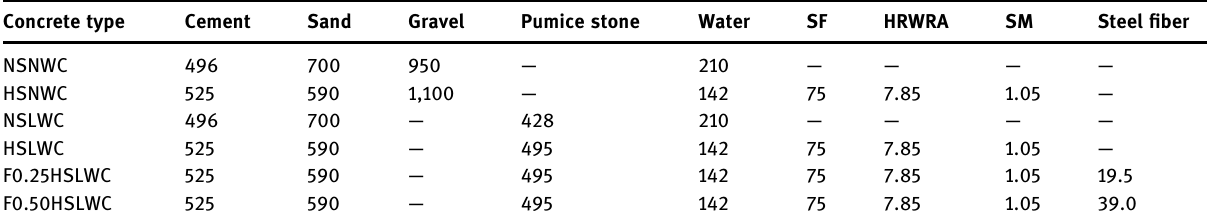
Table 2: Mix proportions for all concrete types Concrete